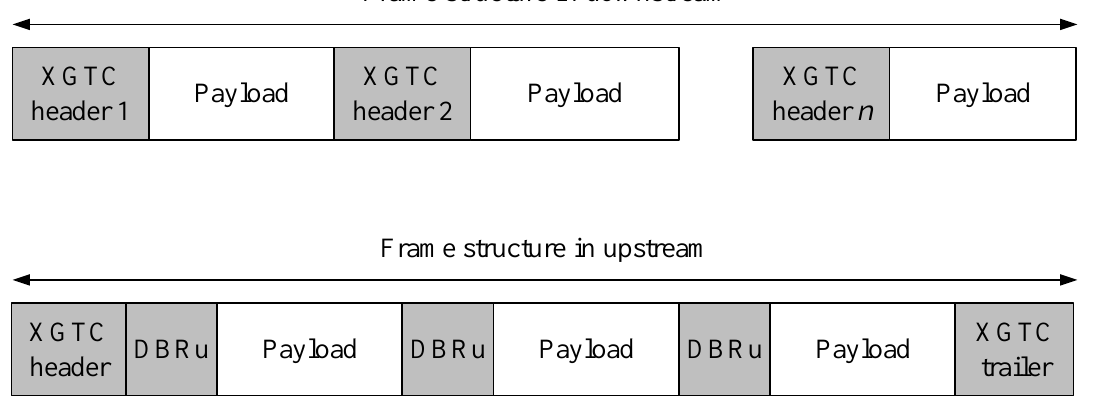
Figure 6. Next-generation passive optical network (XG-PON) frame structures for both